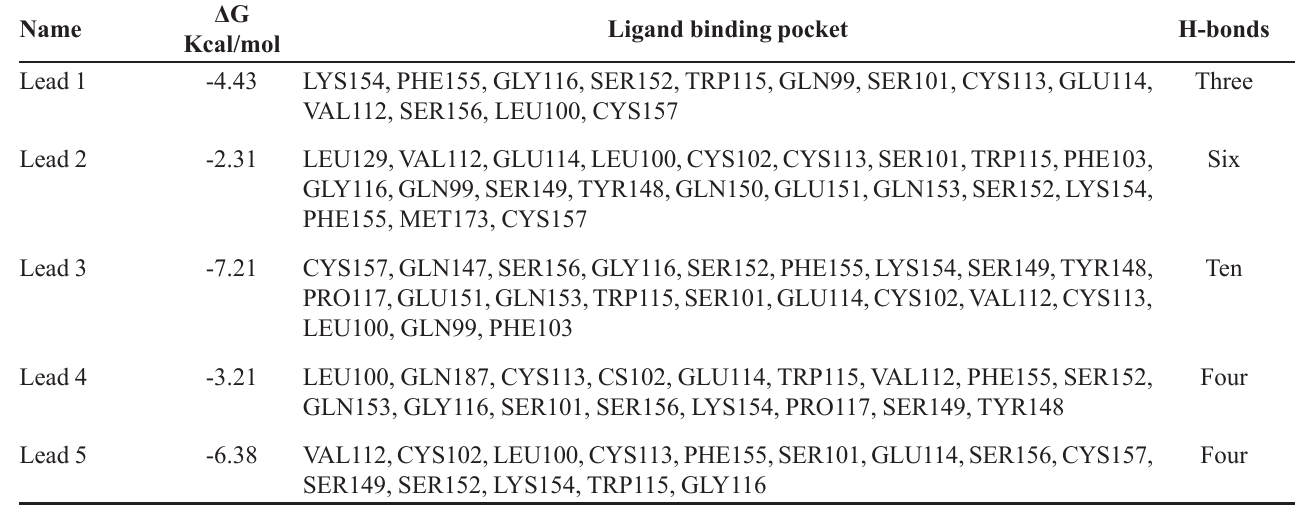
TABLE II - Auto Dock analysis of top five lead natural